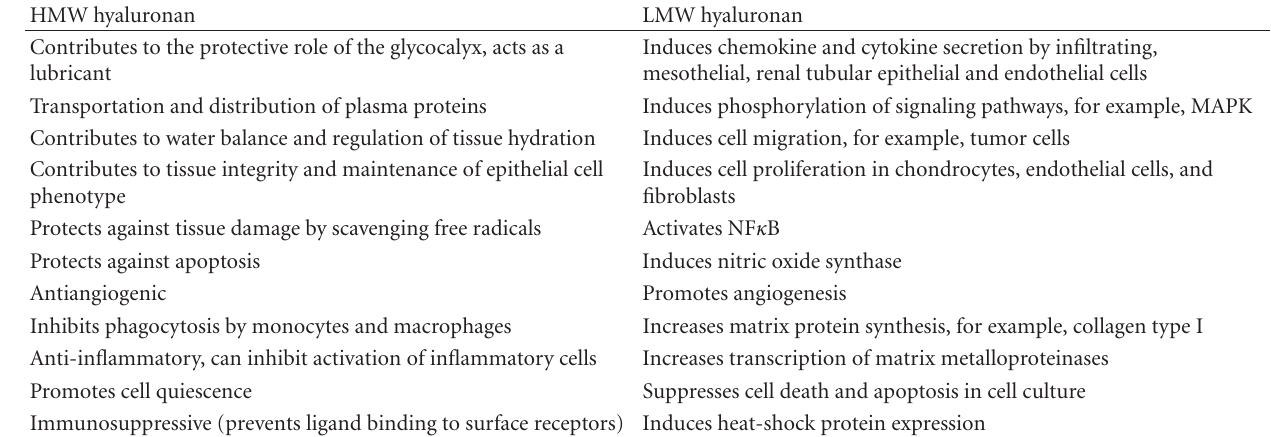
Table 1: Functions of native hyaluronan and its fragments during tissue homeostasis and inflammation. HMW hyaluronan LMW hyaluronan Contributes to the protective role of the glycocalyx, acts as a Induces chemokine and cytokine secretion by infiltrating, lubricant mesothelial, renal tubular epithelial and endothelial cells Transportation and distribution of plasma proteins Induces phosphorylation of signaling pathways, for example, MAPK Contributes to water balance and regulation of tissue hydration Induces cell migration, for example, tumor cells Contributes to tissue integrity and maintenance of epithelial cell Induces cell proliferation in chondrocytes, endothelial cells, and phenotype fibroblasts Protects against tissue damage by scavenging free radicals Activates NF κ B Protects against apoptosis Induces nitric oxide synthase Antiangiogenic Promotes angiogenesis Inhibits phagocytosis by monocytes and macrophages Increases matrix protein synthesis, for example, collagen type I Anti-inflammatory, can inhibit activation of inflammatory cells Increases transcription of matrix metalloproteinases Promotes cell quiescence Suppresses cell death and apoptosis in cell culture Immunosuppressive (prevents ligand binding to surface receptors) Induces heat-shock protein